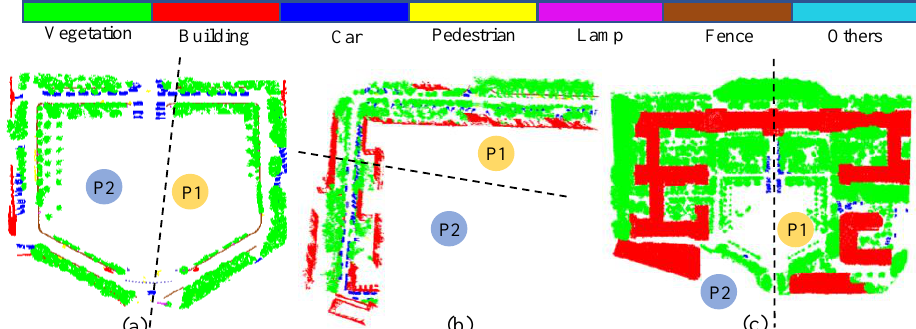
Figure 4. Experimental datasets. (a) and (b) are the MLS point clouds and (c) is the ALS point cloud. Each block is divided into two parts, P1 and P2, by a vertical plane shown with a dash line. P1 is for training and P2 for testing.